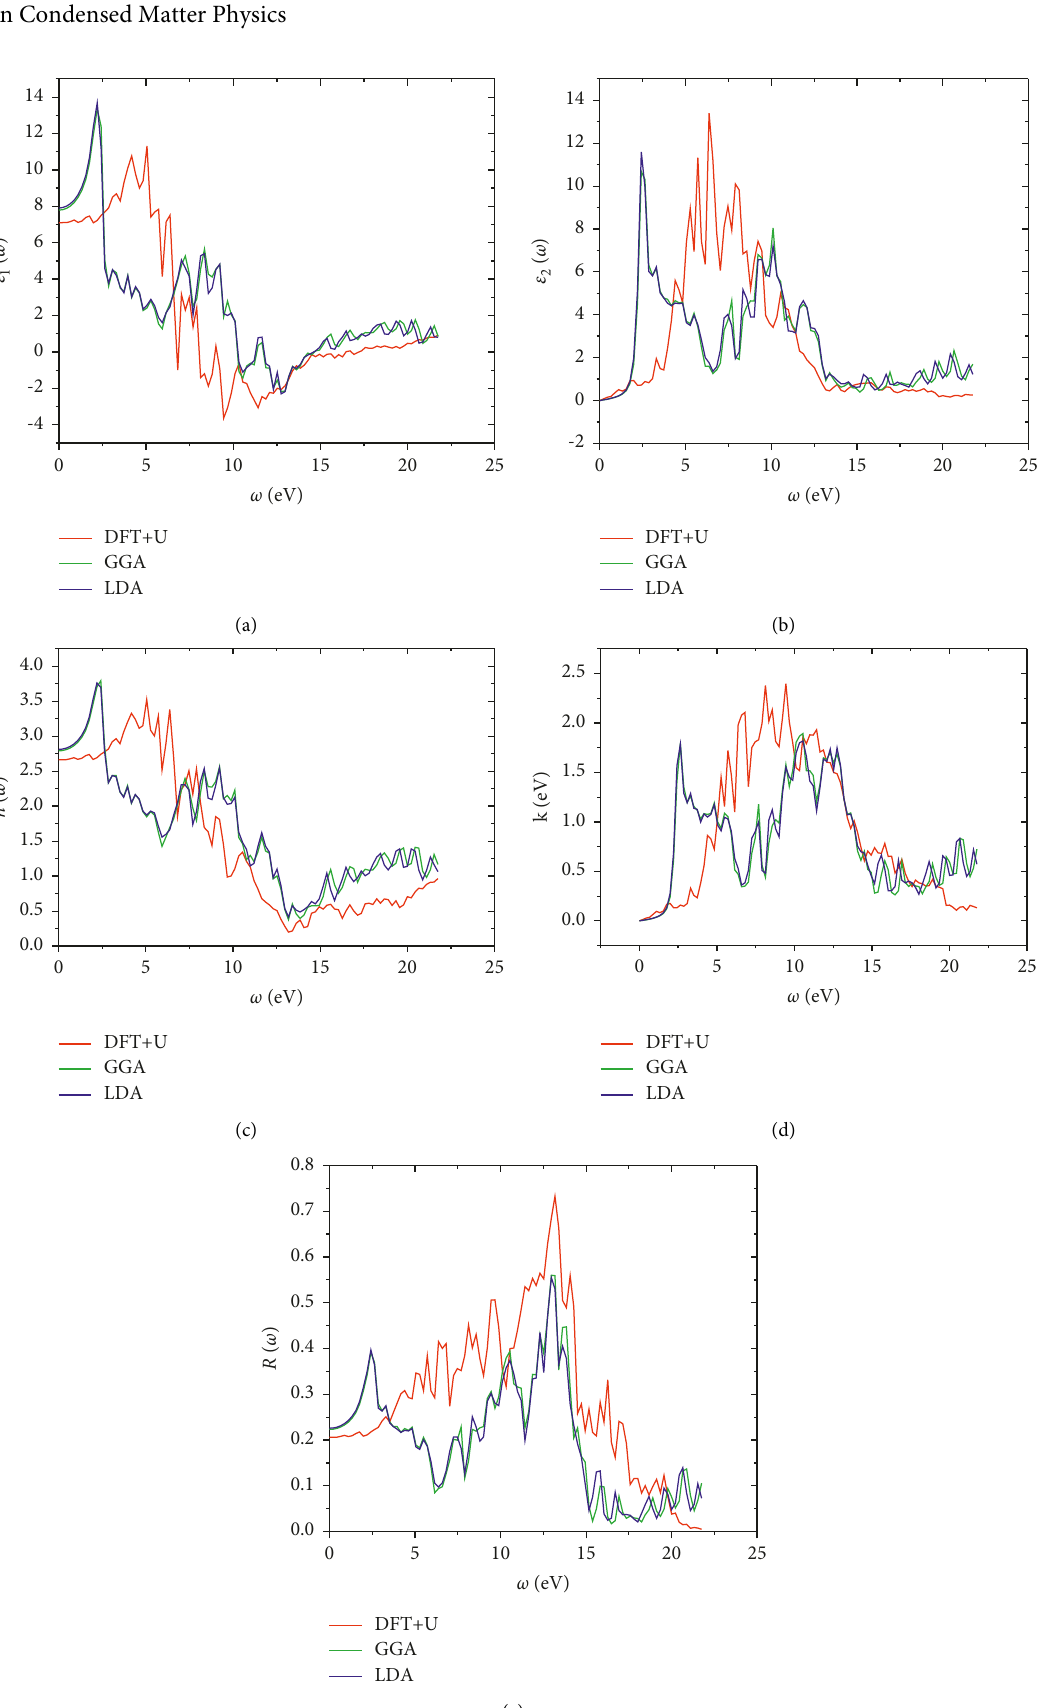
Figure 7: (a) Real dielectric function, (b) imaginary dielectric function, (c) refractive index, (d) extinction coefficient k , and (e) reflectivity of CeO 2